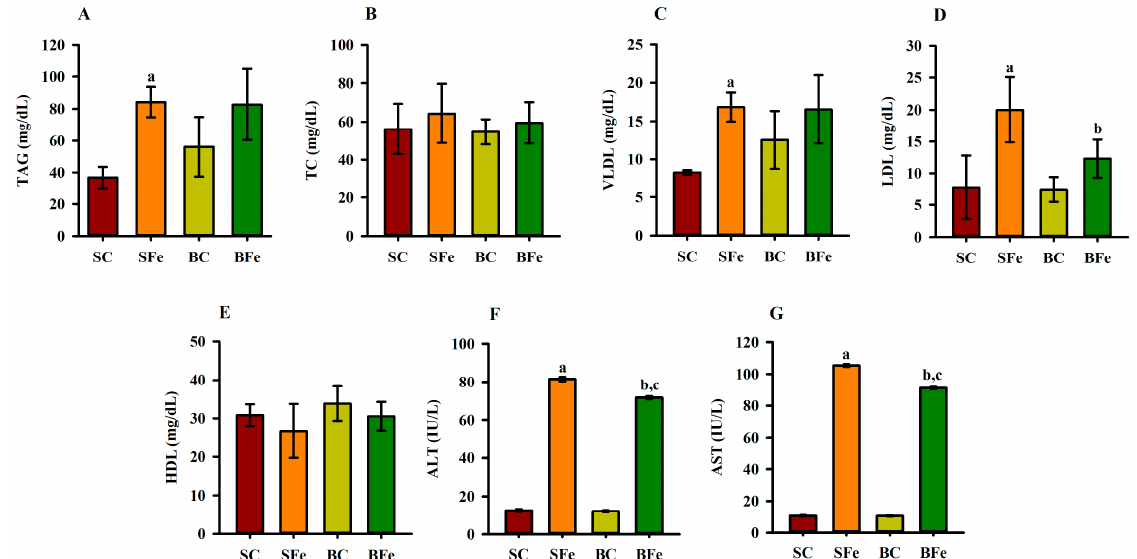
Figure 2. Lipid profile and aminotransferases of rats treated or not with a high dose of FeSO 4 and diets added with either soybean oil or buriti oil. Triacylglycerides ( A ), total cholesterol ( B ), very low density lipoprotein ( C ), low-density lipoprotein ( D ), high-density lipoprotein ( E ), alanine aminotransferase ( F ), and aspartate aminotransferase ( G ). SC = control group fed diet containing soybean oil and gavage with saline solution; BC = control group fed a diet containing buriti oil and gavage with saline solution; SFe = group fed a diet containing soybean oil and gavage with a high-dose FeSO 4 ; BFe = group fed a diet containing buriti oil and gavage with a high-dose FeSO 4 . HDL = high-density lipoprotein; LDL = low-density lipoprotein; TAG = triacylglycerides; TC = total cholesterol; VLDL = very low density lipoprotein. a Represents a significant difference compared with the SC; b Represents a significant difference compared with the SFe; c Represents a significant difference compared with the BC. Values in the vertical bars are mean ± SD of each rat group (Student’s t -test, p ≤ 0.05; n = 8